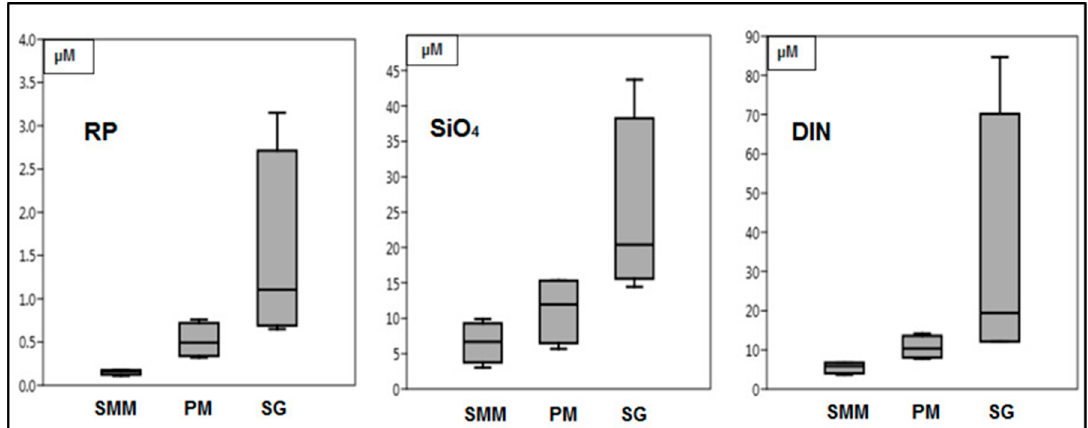
Figure 2. Concentrations of reactive phosphorus (RP), silicates (SiO 4 ), and dissolved inorganic nitrogen (DIN) ( μ M) in the water column of LV. SMM: Santa Maria del Mare, PM: Porto Marghera, and SG: San Giuliano.